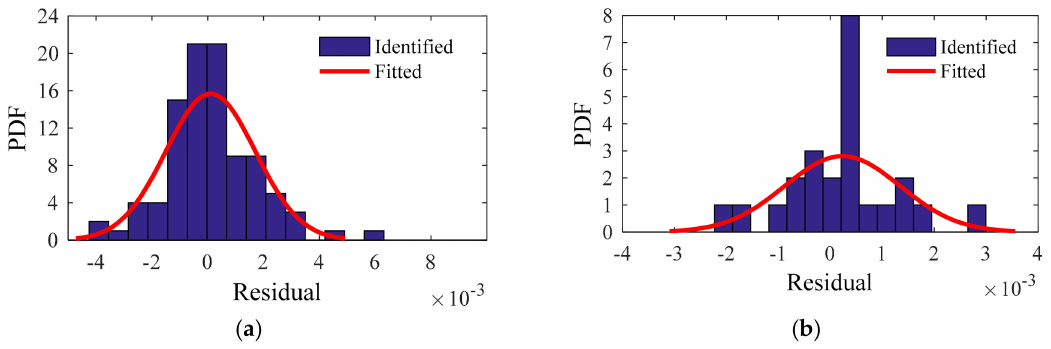
Figure 21. Fourth modal frequency: identified PDF and fitted PDF of the residual: ( a ) Training sample; ( b ) Testing sample.